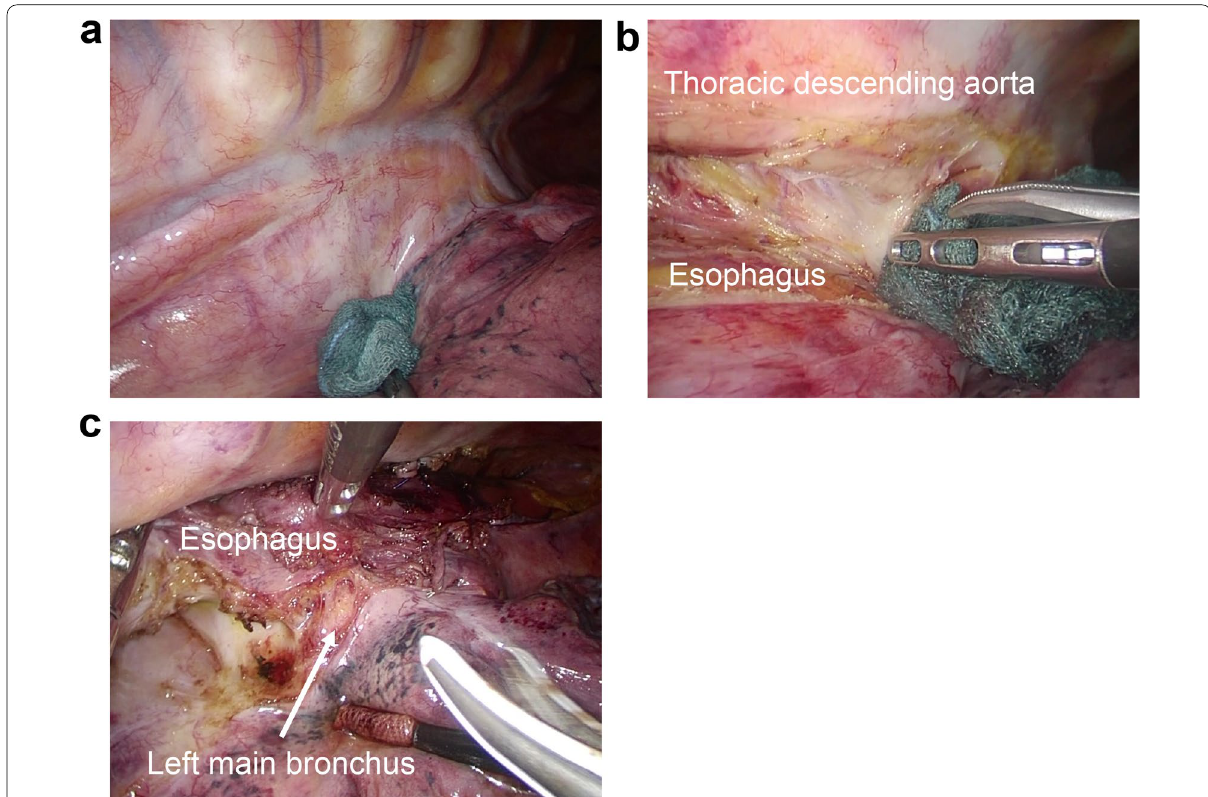
Fig. 3 Intraoperative findings. a The tumor was located in the middle esophagus. The esophageal adventitia had white scarring. b , c The esophagus tightly adhered to the thoracic descending aorta and left main bronchus